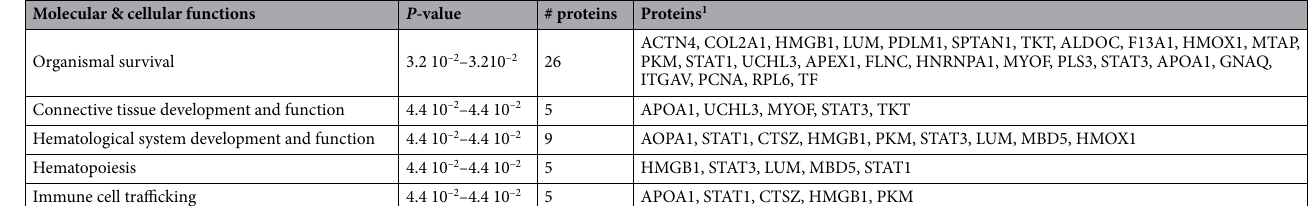
Table 7. Top physiological system development and function for DE proteins in broiler tibiae with BCO. 1 ACTN4, Actinin alpha 4; ALDOC, Aldolase, fructose-bisphosphate C; APEX1,